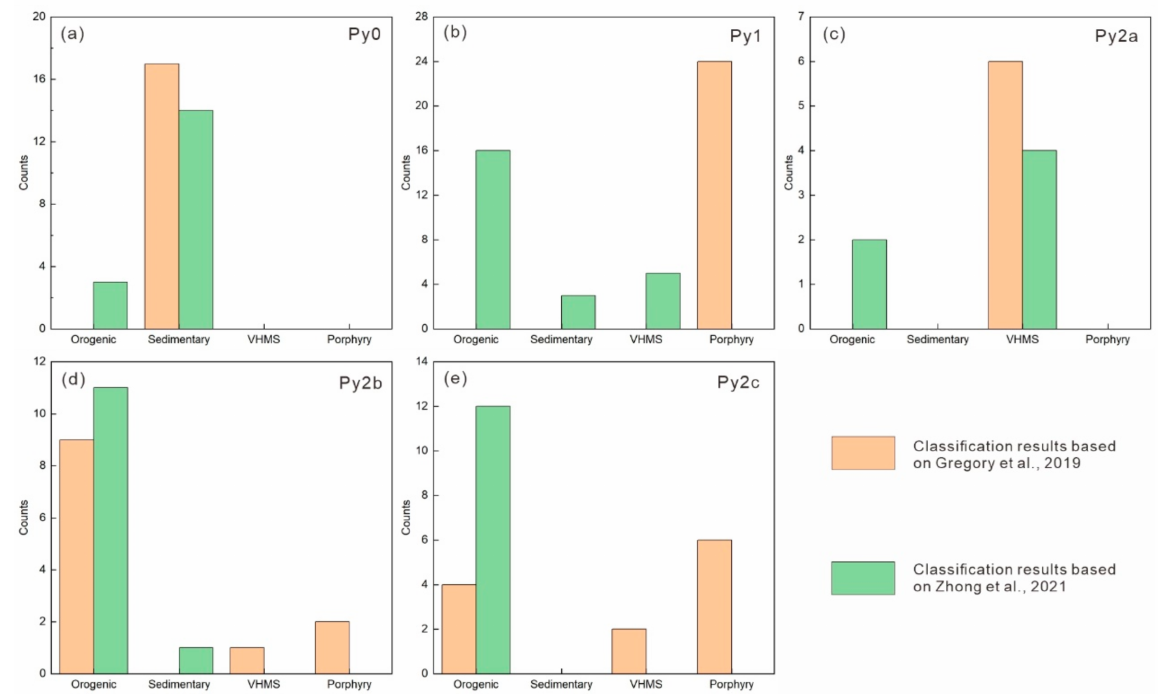
Figure 13. Classification result histograms for Py0 ( a ), Py1 ( b ), Py2a ( c ), Py2b ( d ), and Py2c ( e ) from the Dunbasitao gold deposit based on two different machine learning classifiers developed by Gregory et al. [22] and Zhong et al. [23]. Note that the latter could only discriminate orogenic, sedimentary, and VHMS